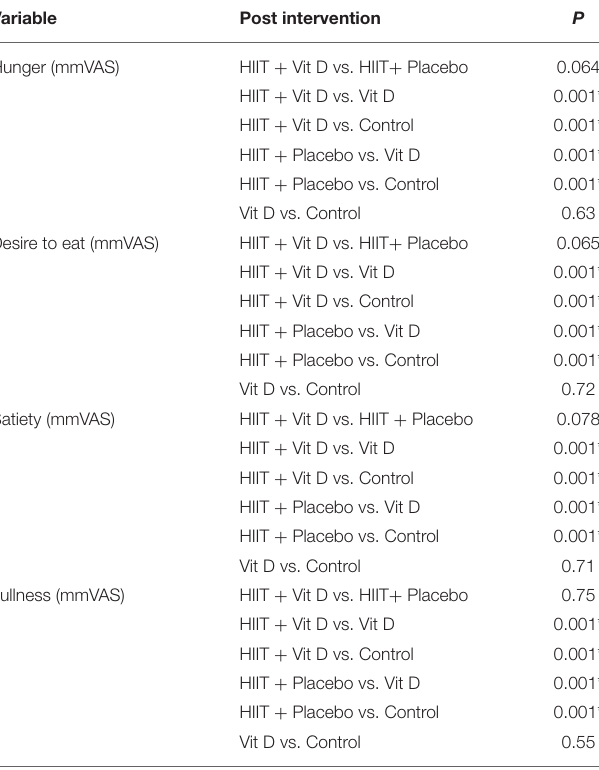
TABLE 3 | Appetite assess using visual analog scale (VAS). Variable